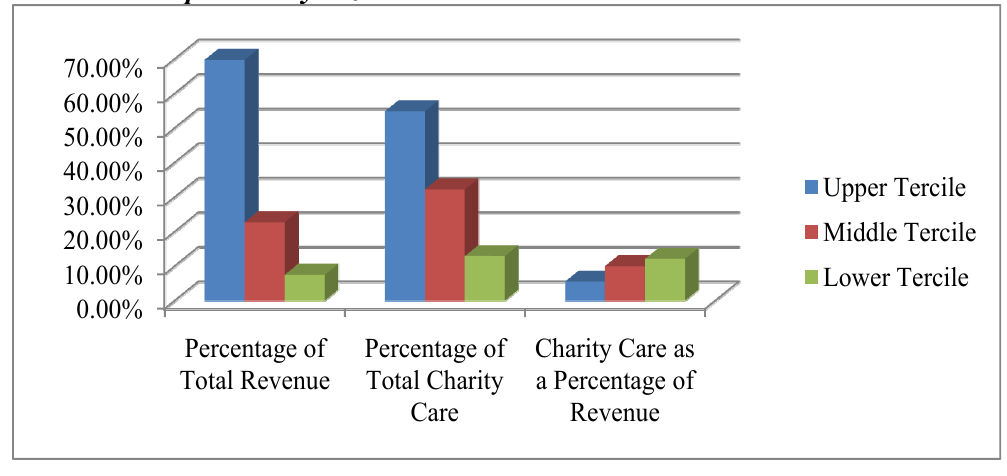
Panel B: Comparison by Location